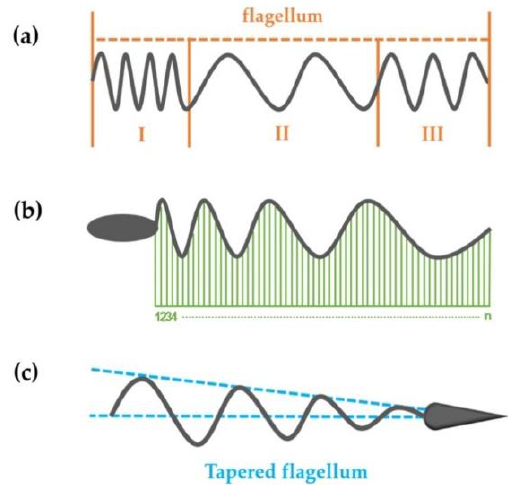
Figure 8. Three types of flagella. ( a ) The flagellum is composed of multiple segments of flagella with different pitches. ( b ) The flagellum with uniformly increased or decreased pitch. ( c ) The flagellum has a tapered helical structure like which has been discussed above.